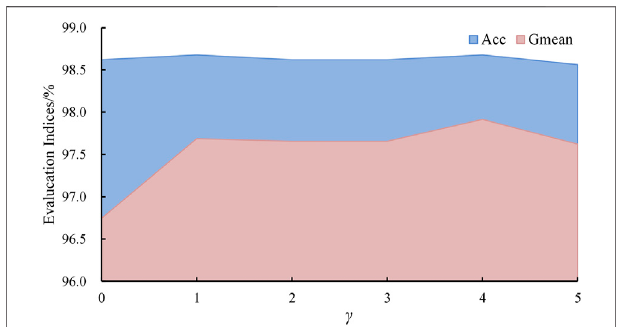
FIGURE 8 | Evaluation performance of the model in different γ values.